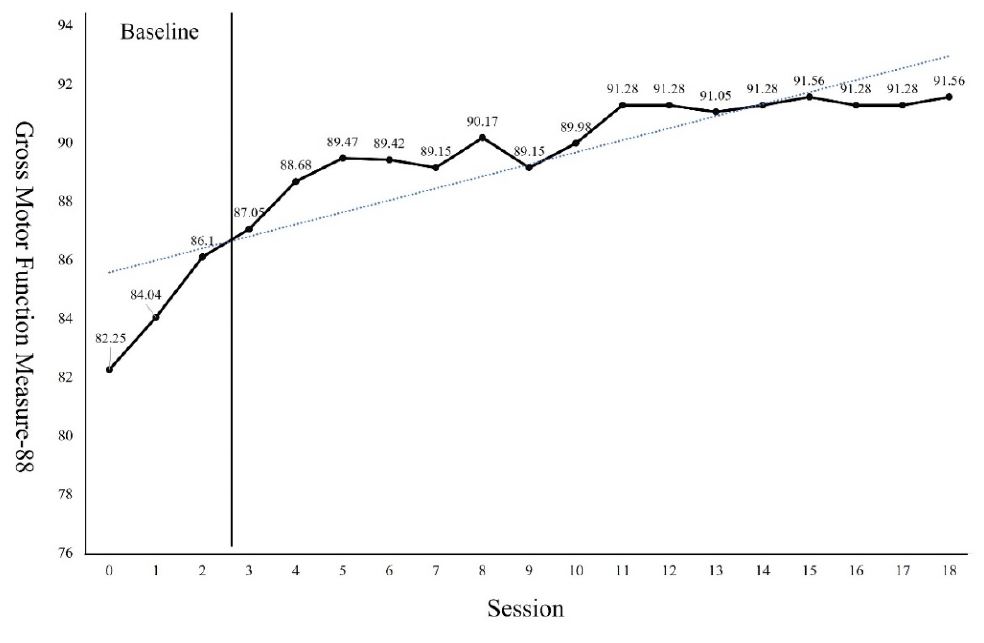
Figure 2. Changes of Gross Motor Function Measure.